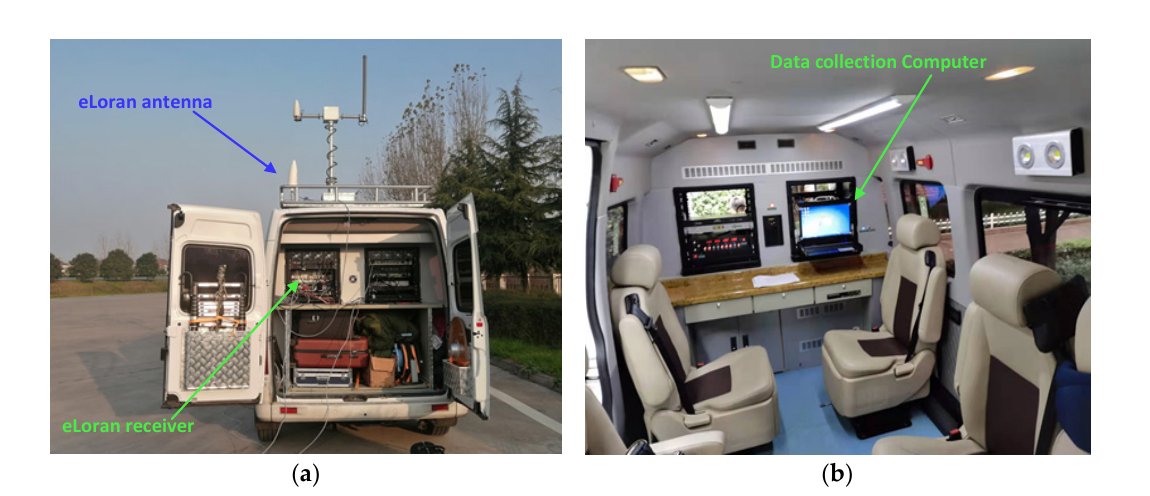
Figure 11. Test platform for cycle identification method: ( a ) outside of the test platform; ( b ) inside of the test platform.